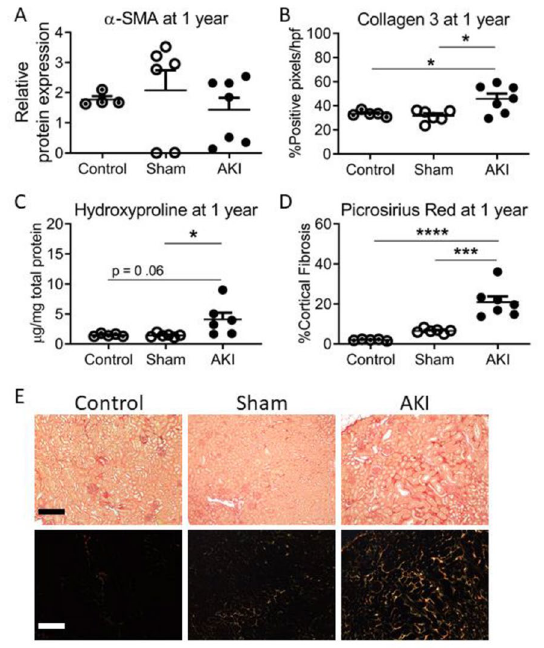
Figure 3. Markers of kidney inflammation and fibrosis in females 1 year after AKI or sham, compared to healthy age-matched controls. Quantification of α-SMA ( A ) and of fibrosis via Collagen 3 immunohistochemistry ( B ), Hydoxyproline content ( C ) and Picrosirius Red ( D ), showed no difference in α-SMA content, but an increase in fibrosis at 12 months in the AKI compared to control and sham cohorts. (n = 5–7) *, **, *** and ****Signify P < 0.05, P < 0.01, P < 0.001 and P < 0.0001, respectively. ( E ) Representative Picrosirius Red images. Top panel, light microscopy; Bottom panel, polarized images. Magnification, ×200. Scale bar = 10 µM.